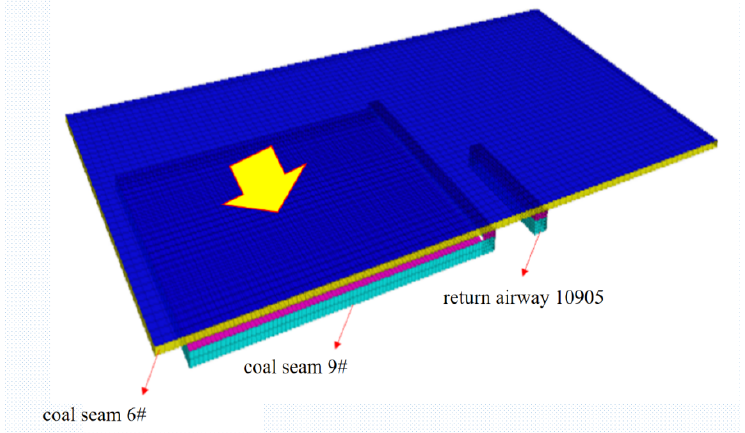
Figure 13. Model excavation scheme.